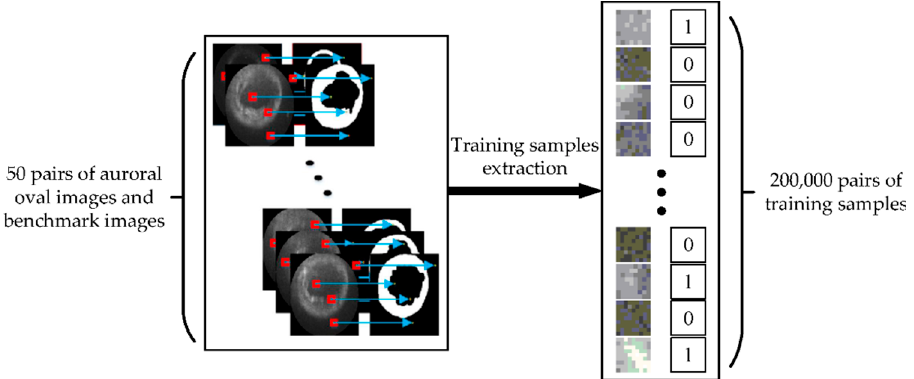
Figure 9. Extract training samples from the auroral oval images.